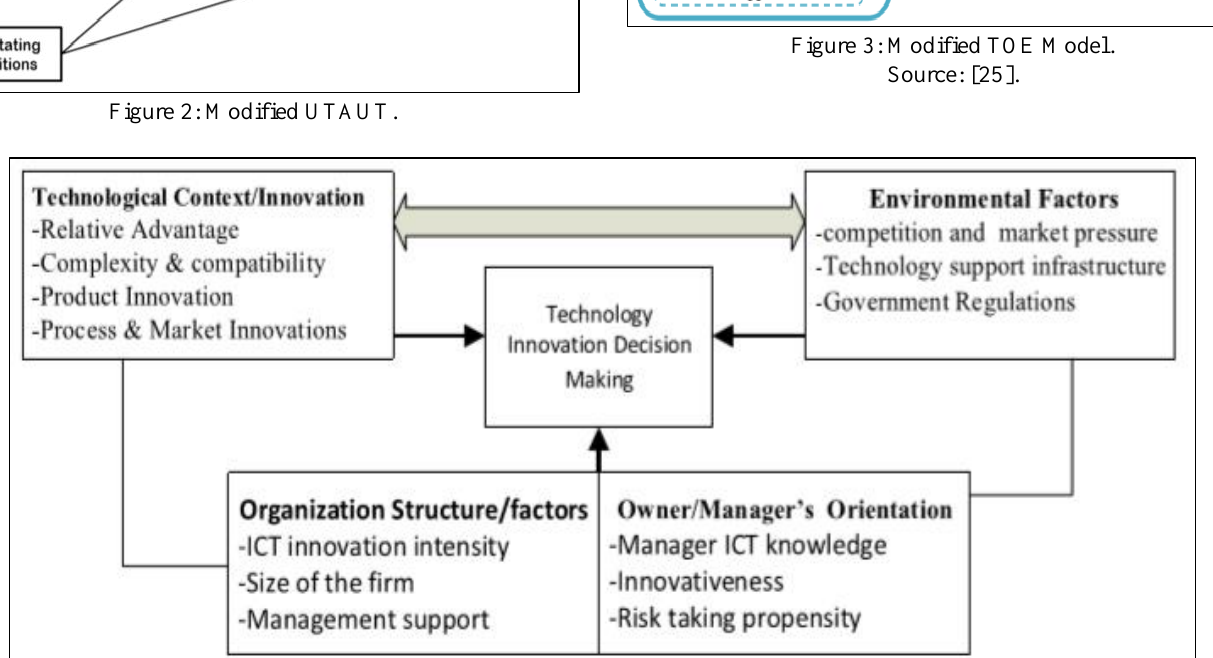
Figure 4: Modified TOE Model. Source: